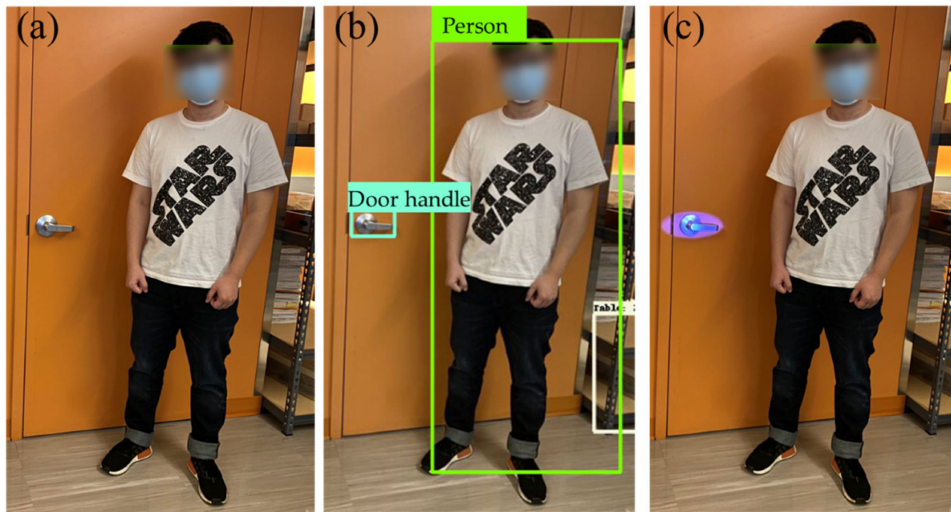
Figure 3. ( a ) Original image of a person standing in front of a door; ( b ) image recognition result with Deep Learning; ( c ) the area that needs to be disinfected is illuminated.